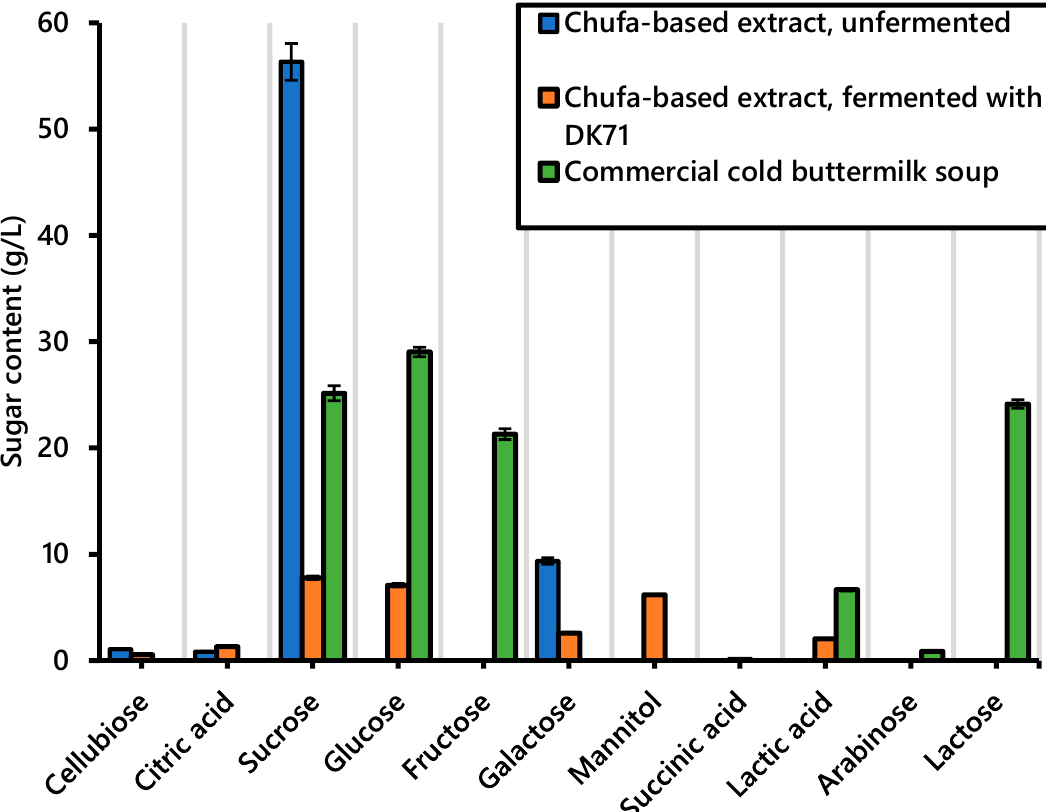
Figure 2. Sugar profile of unfermented chufa-based extract, fermented chufa-based extract, and a commercial cold buttermilk soup. Data are presented as mean values of triplicates. The error bars represent the standard deviation.